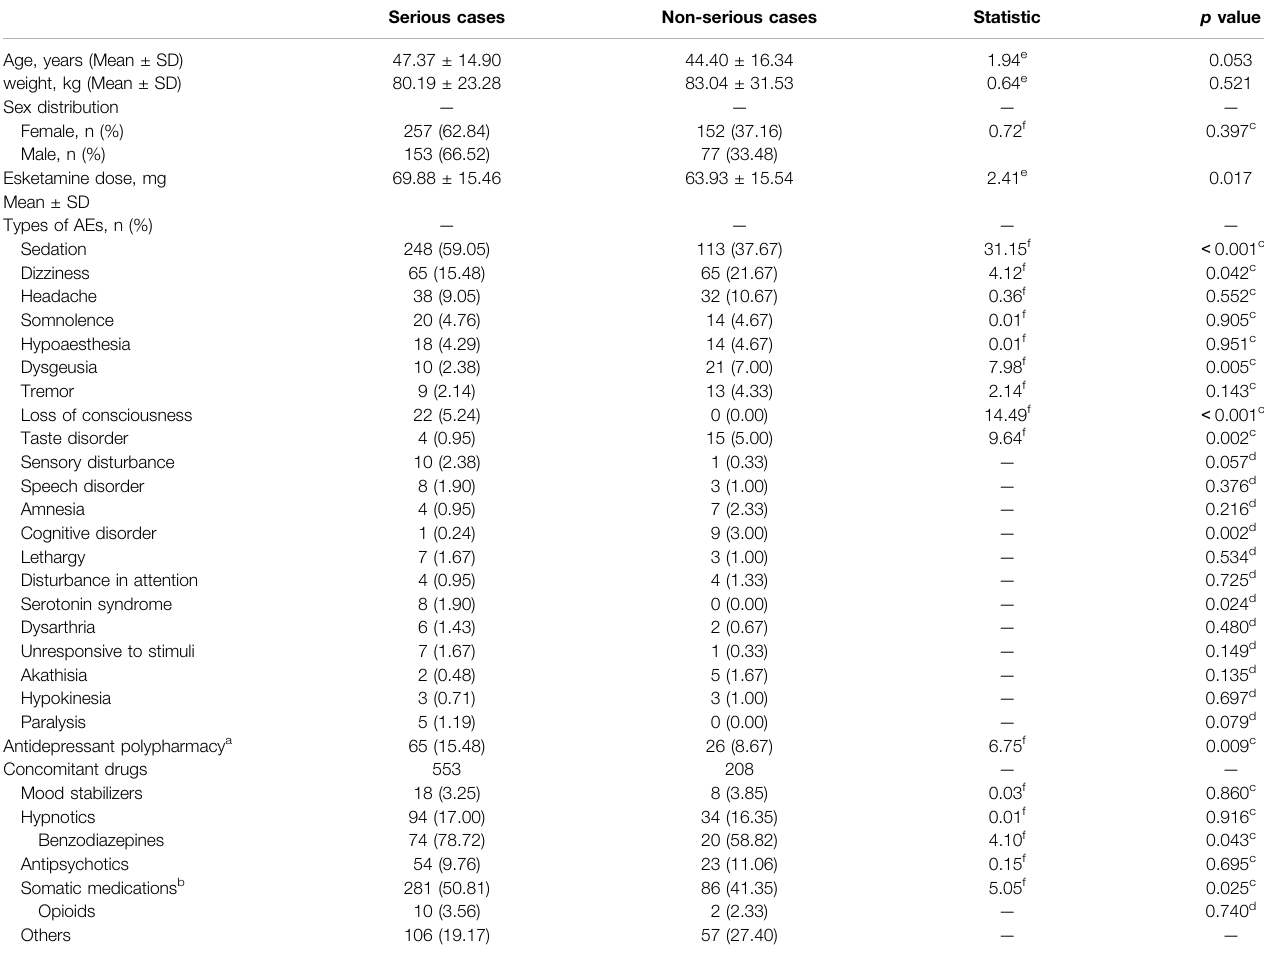
TABLE 2 | Differences in clinical characteristics of severe and non-severe